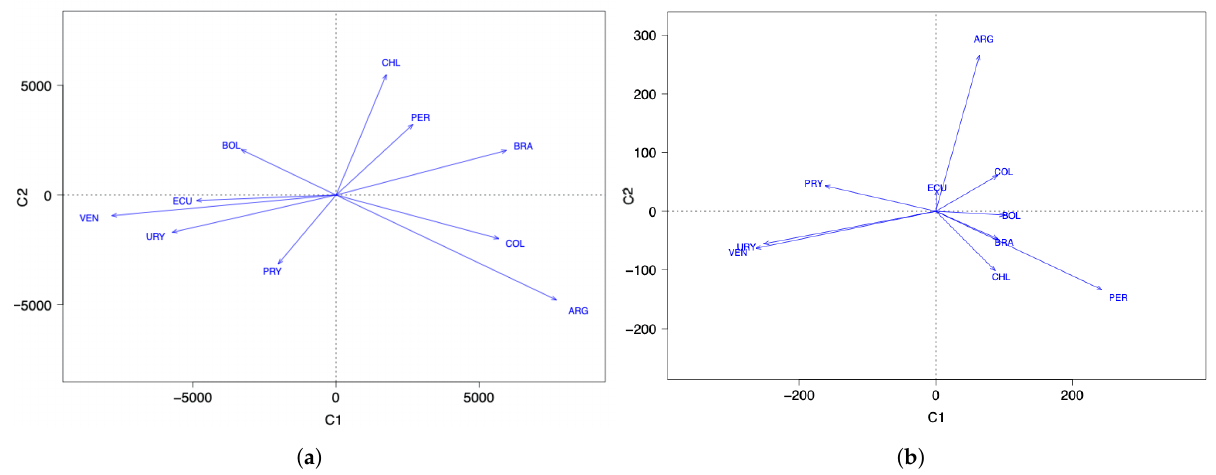
Figure 6. FPCA space of countries for data on the number of COVID-19 ( a ) infected cases and ( b ) deaths. Table 7. Loading matrix for data on the number of COVID infected cases with two components (C1 and C2) for the indicated country using the